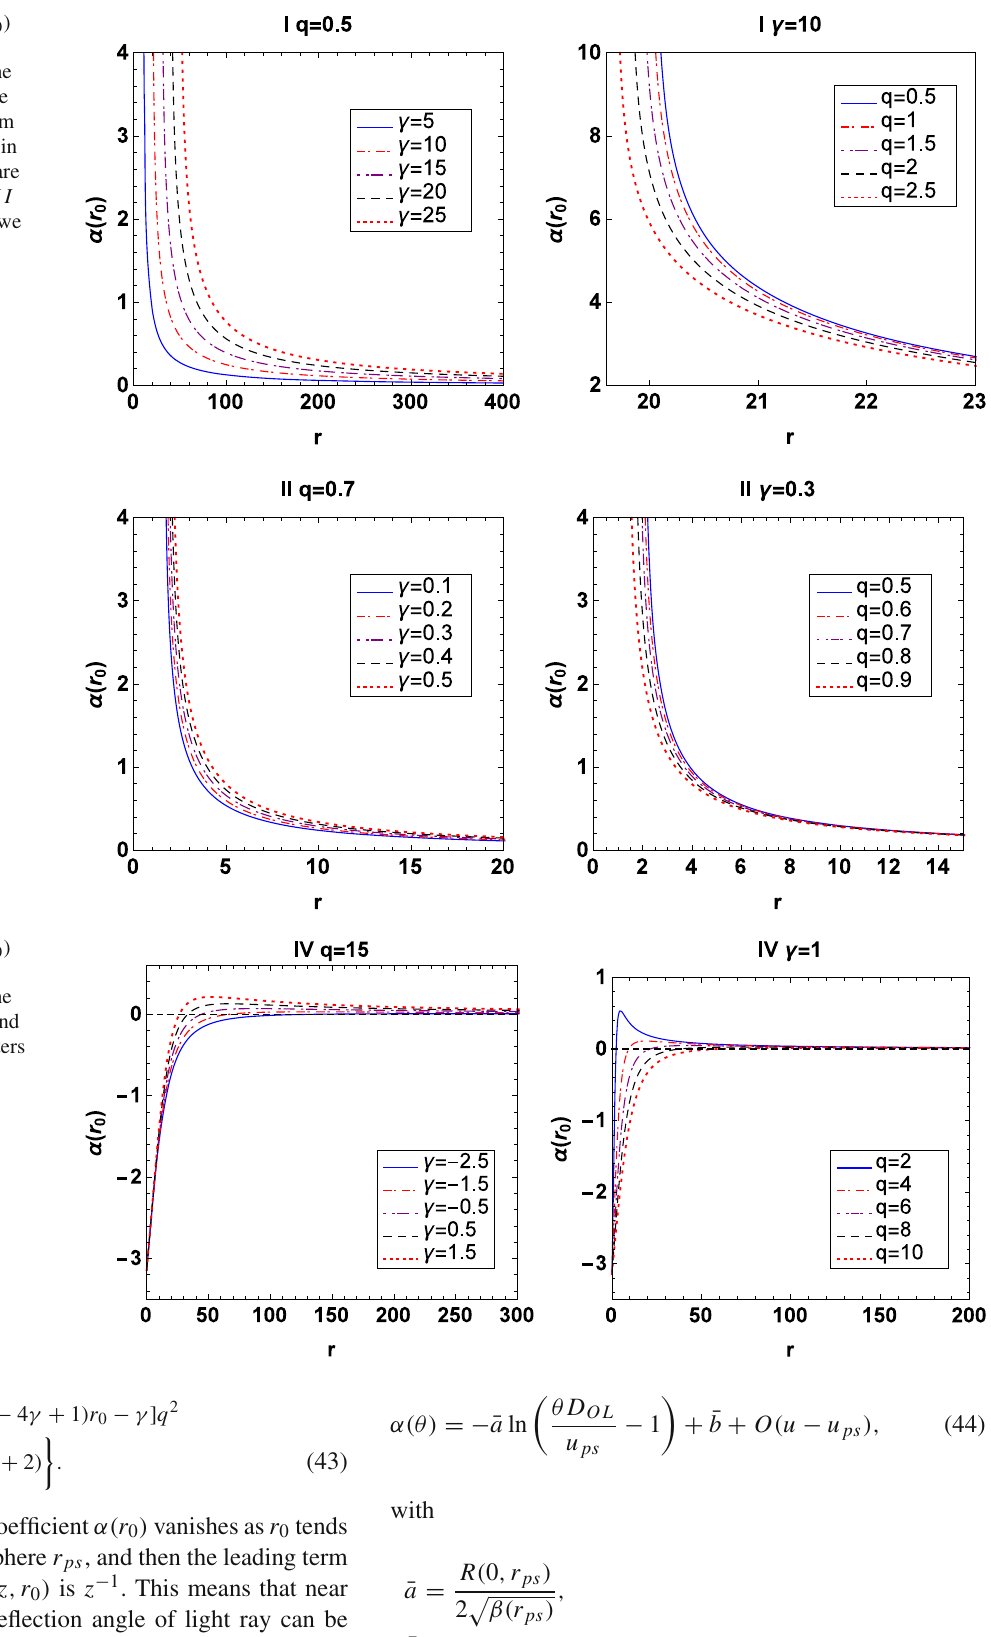
Fig. 3 Deflection angle α( r 0 ) as a function of the closest distance of approach r 0 for the cases with photon sphere. The panels in the upper and bottom rows correspond to the cases in which the parameters ( γ, q ) are located in the regions I and I